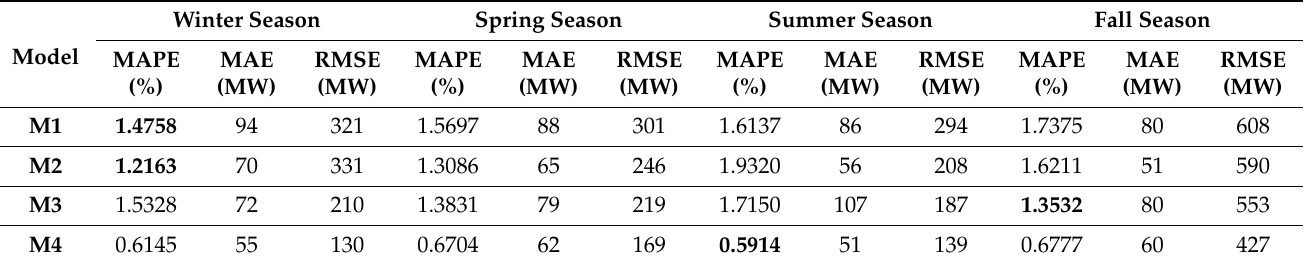
Table 4. Seasonal forecasted